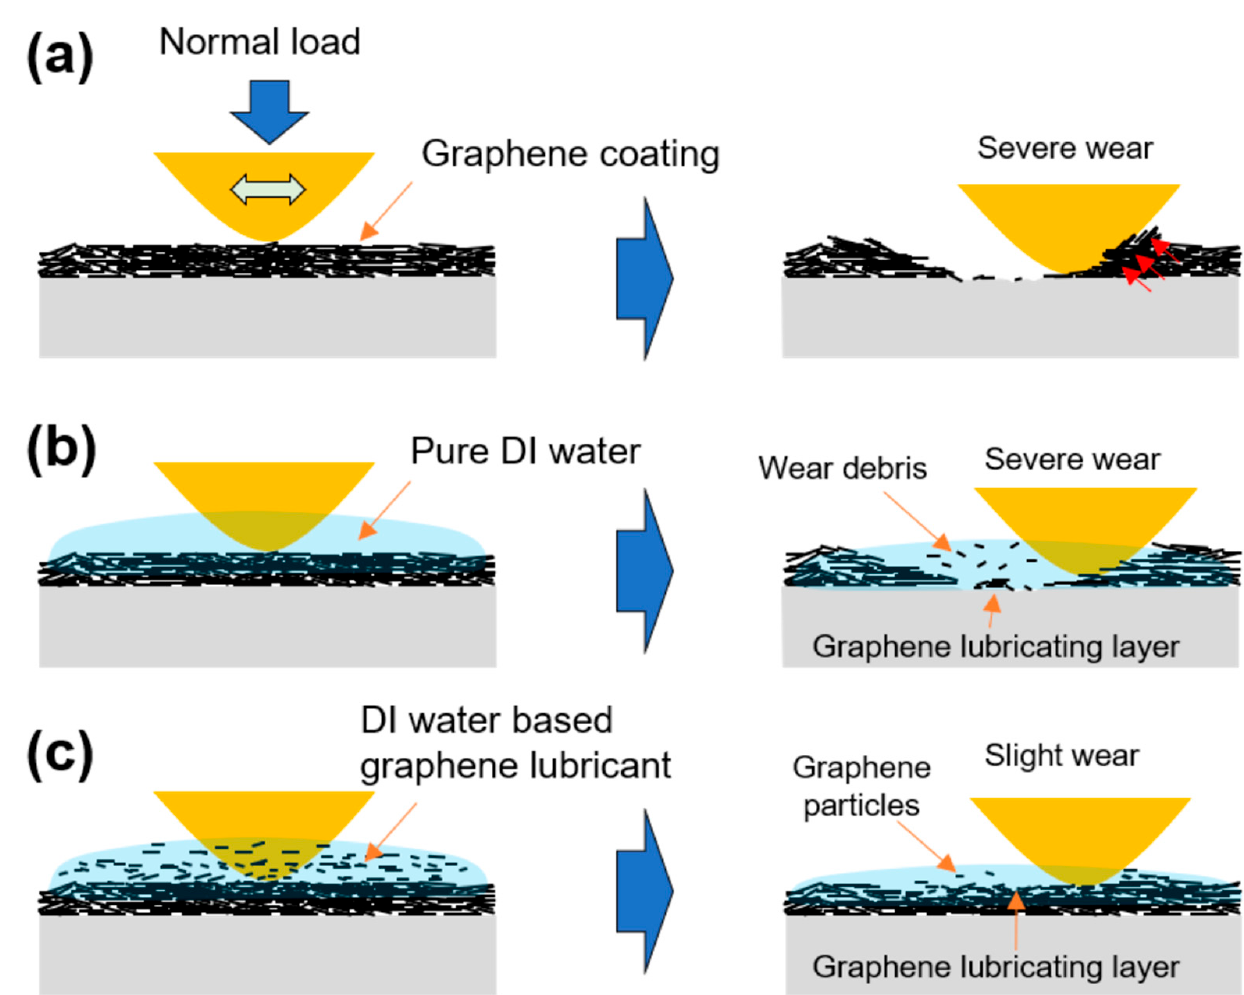
Figure 6. Schematic design of wear mechanism of graphene coating under ( a ) dry, ( b ) pure DI water and ( c ) DI water-based graphene lubricant conditions.